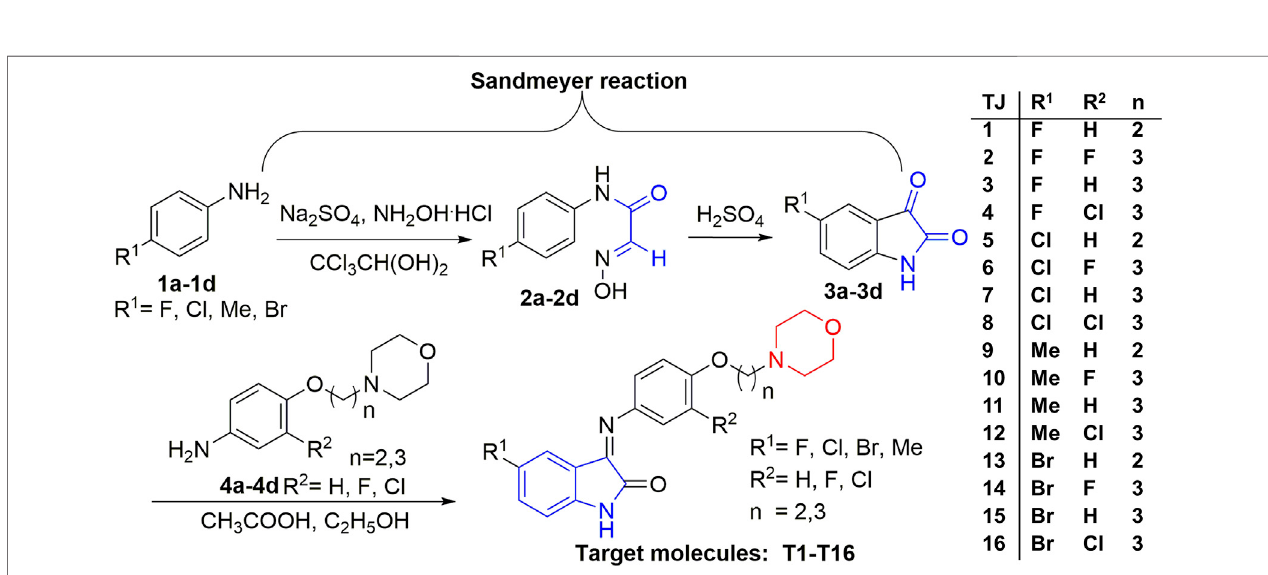
FIGURE 4 | Simulated 3D complex structure of compound T10 with its target Kv1.5 channel using Sur fl ex Docking. (A) T10 was shown in the surface while Kv1.5 was shown in the cyan cartoon. (B) Binding site around compound T10 (shown in mesh) was shown in the cyan cartoon. (C) Hydrogen bond (blue line) was formed between 1 H of indole and O of the carbonyl group on the backbone of Thr479 amino acid residue.